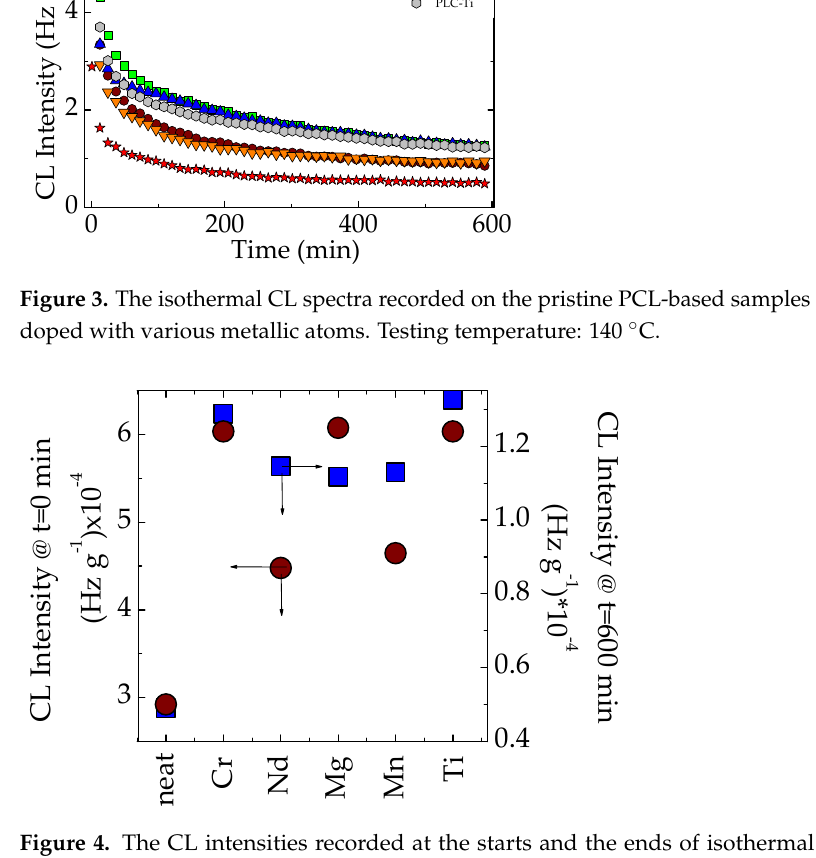
Figure 4. The CL intensities recorded at the starts and the ends of isothermal measurements on unirradiated PbZrO 3 doped with various metallic atoms. The degradation time is expressed in minutes. Testing temperature: 140 °C.